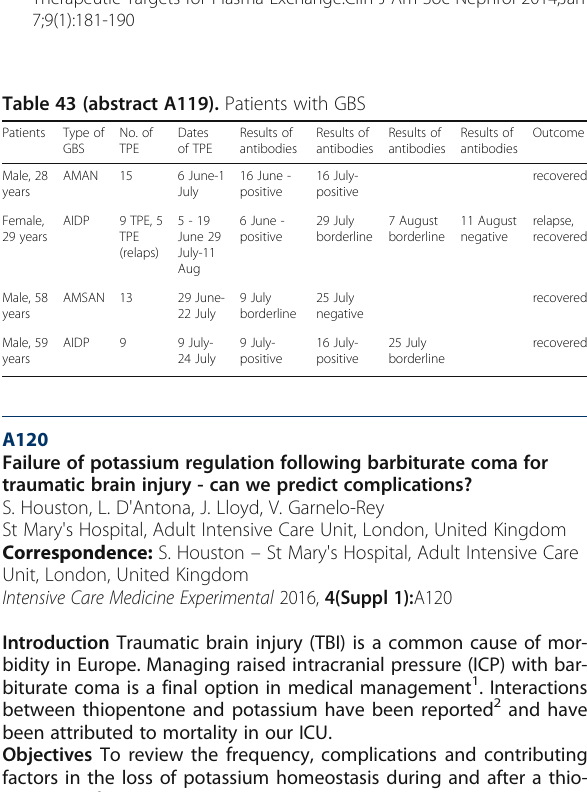
Fig. 47 (abstract A120). Table 45 (abstract A120). Hypokalaemia during infusion